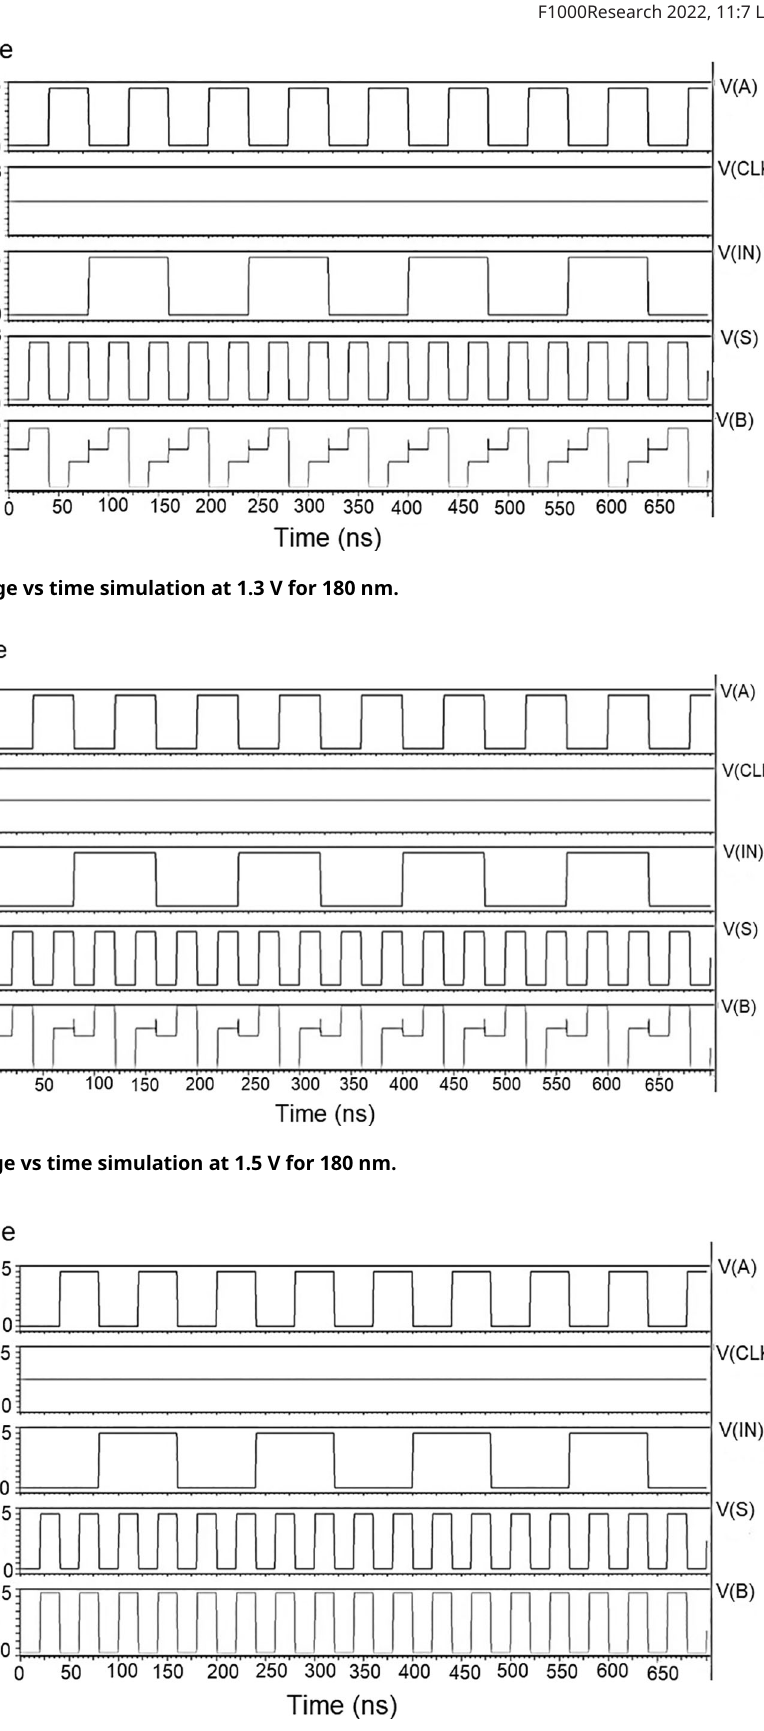
Figure 7(d). Voltage vs time simulation at 2.5 V for 180 nm.